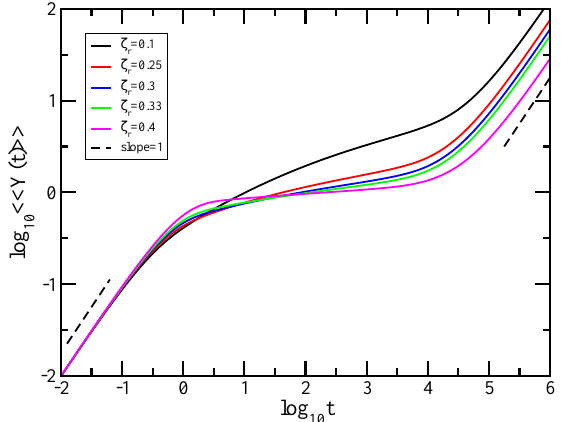
Figure 7. Averaged monomer displacement << Y ( t ) >> of the fractal cactus network under the action of external forces in the Zimm model. Displayed in dimensionless units are the results for the network size N = 3 8 and hydrodynamic interaction strength ζ r = 0.1, 0.25, 0.3, 0.33, and 0.4. For guidance, the black dashed lines indicate that the slope equals